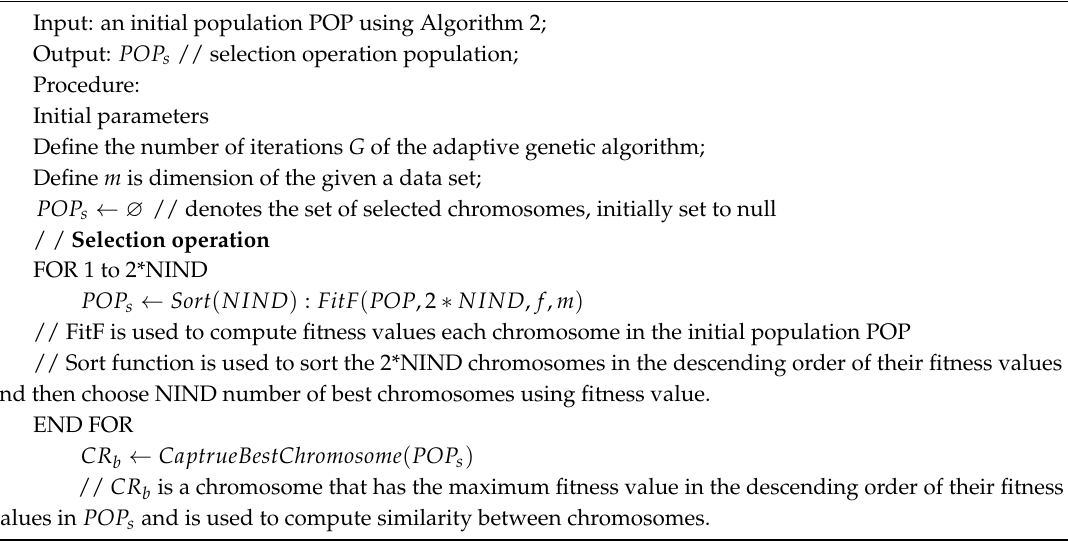
Algorithm 3. Selection operation algorithm of